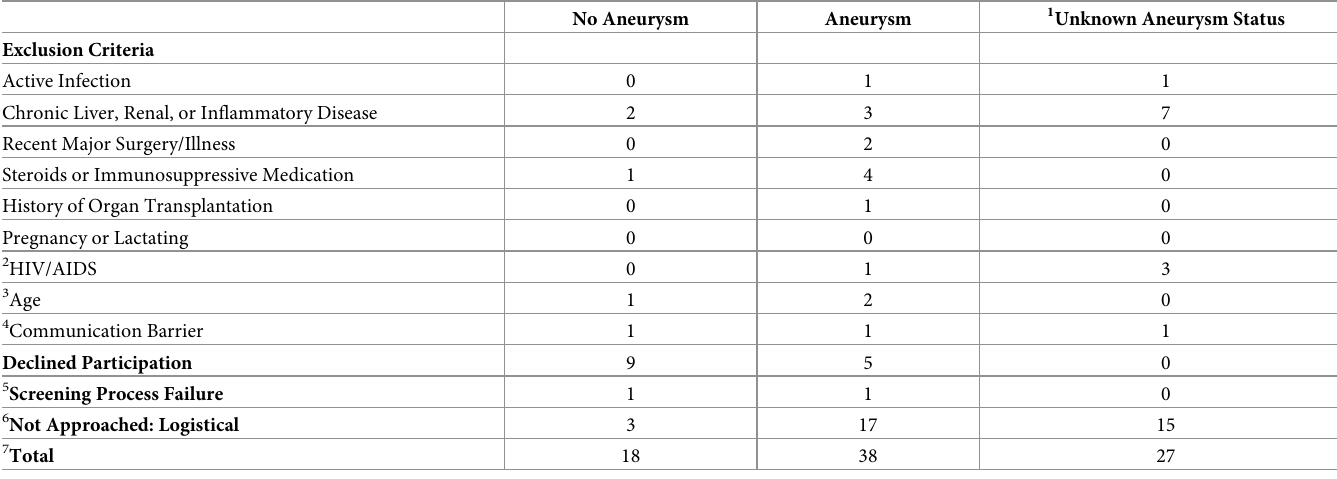
Table 2. Patients excluded from